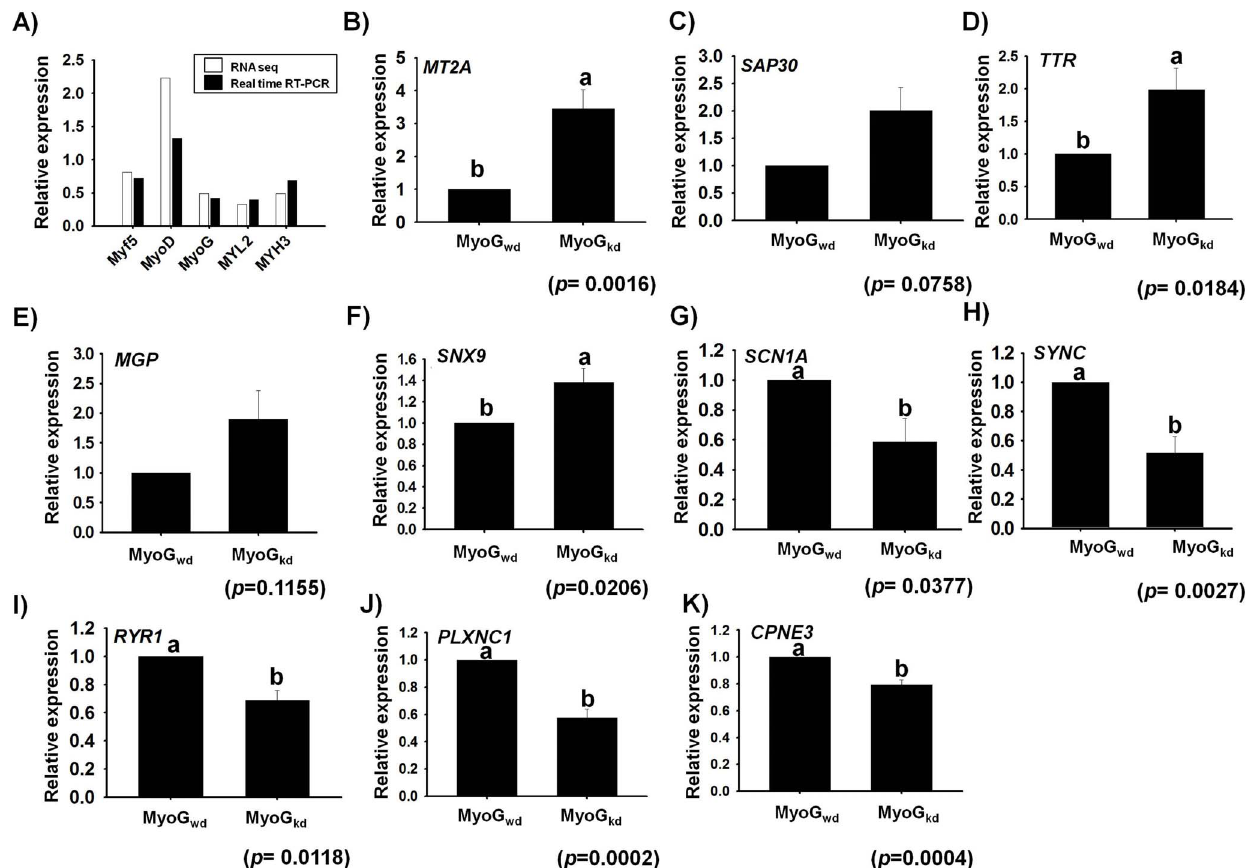
Figure 4. Real time RT-PCR validation of muscle specific and differentially expressed genes on MyoG kd . A ) Fold changes of Myf5 , MyoD , MyoG , MYL2 , and MYH3 genes determined by RNA sequencing were compared with real-time RT PCR results. B–K ) RT-PCR validation of mRNA expression for five randomly selected genes confirmed the increased expression of MT2A SAP30 , TTR , MGP , and SNX9 genes and decreased expression of SCN1A , SYNC , RYR1, PLXNC1 , and CPNE3 genes by MyoG kd . MyoG wd represents control, respectively (mean 6 S.D., n=3). p -value indicates the statistical significance of the data and different letters (a and b) in graph show significant differences among groups.